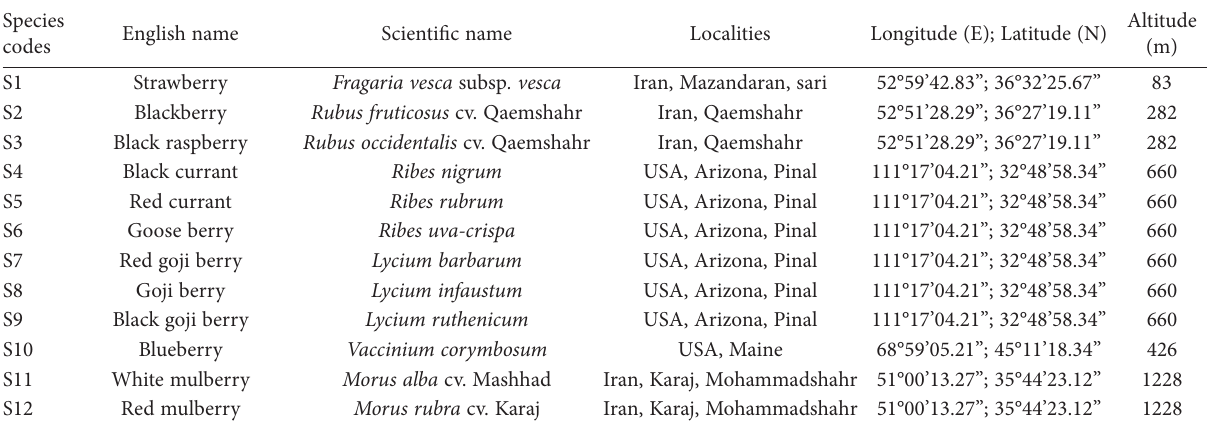
Table 1. Specifications of berry species collection sites (Berry spp.) used in this research.